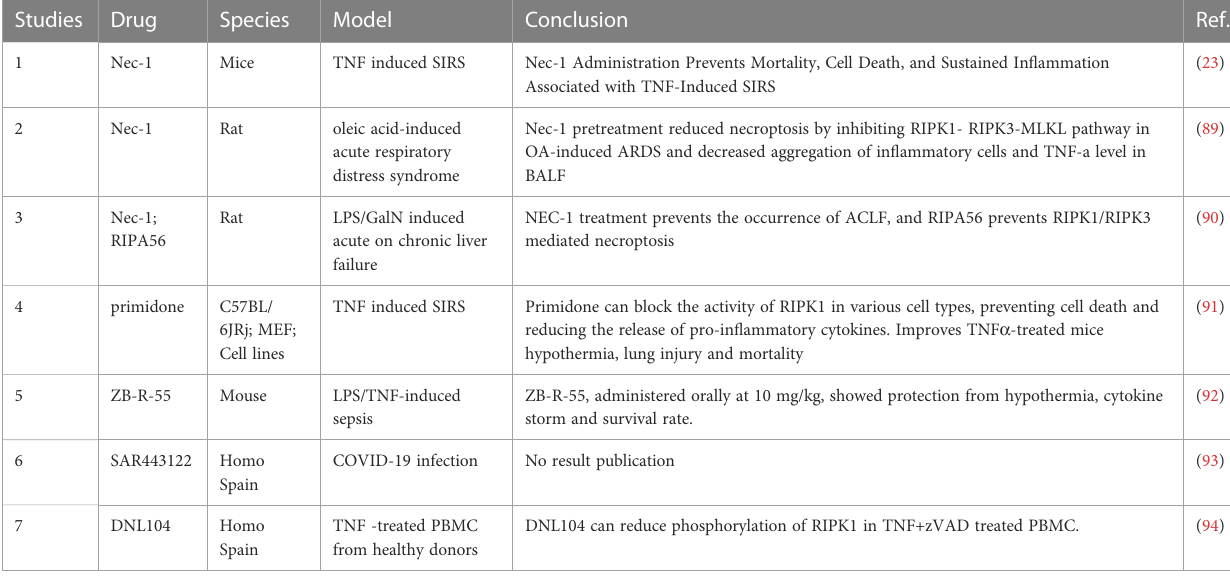
TABLE 5 RIPK1 inhibitors and their effect.